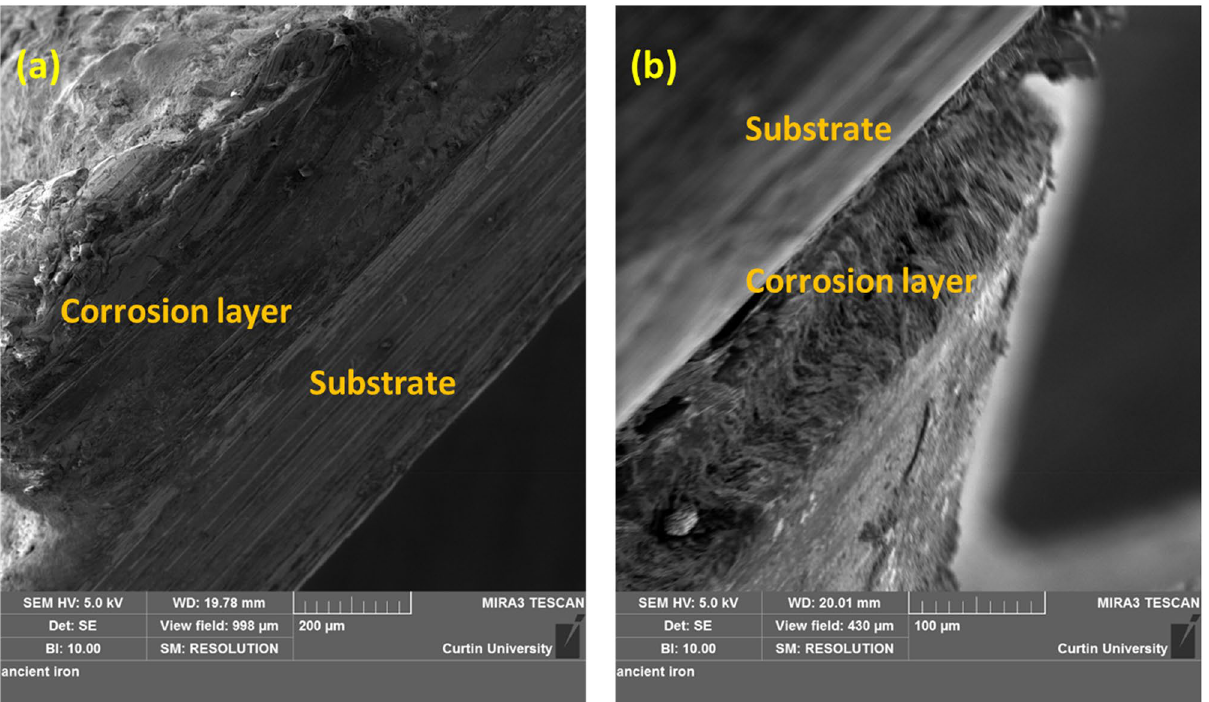
Figure 4. Cross-sectional FESEM images of corrosion product film formed on iron made through ancient Indian metallurgical methods depicting ( a ) interface formation between corrosion product film and substrate (iron) ( b ) interface formation between corrosion product film and substrate (iron) at different location and in different (view) orientation depicting the small holes on